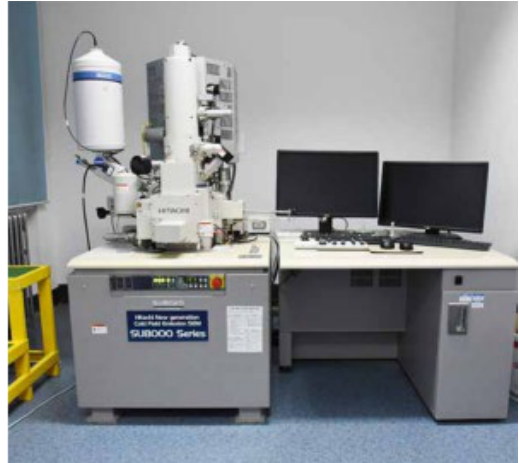
Figure 6. Field emission electron microscope.